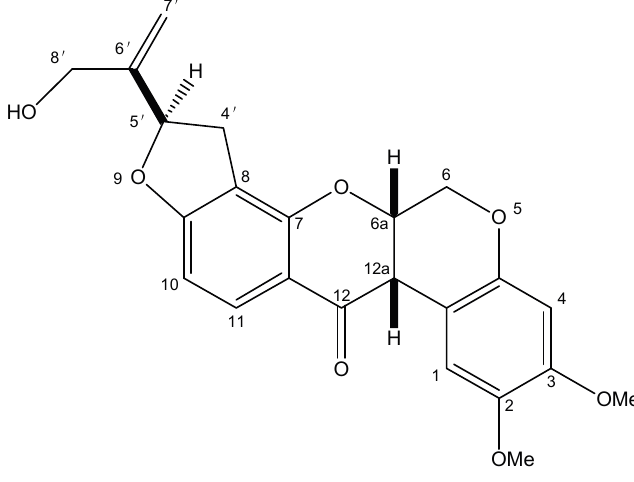
Figure 1. Chemical structure of